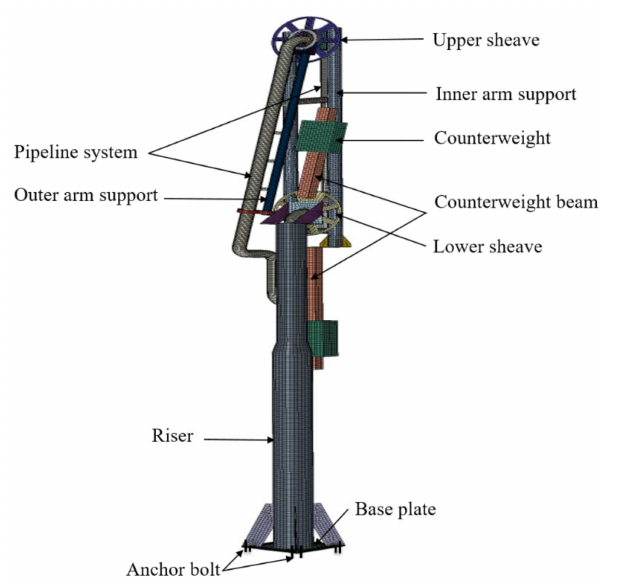
Figure 4. Finite-element model with main components of a typical unloading arm of this study.